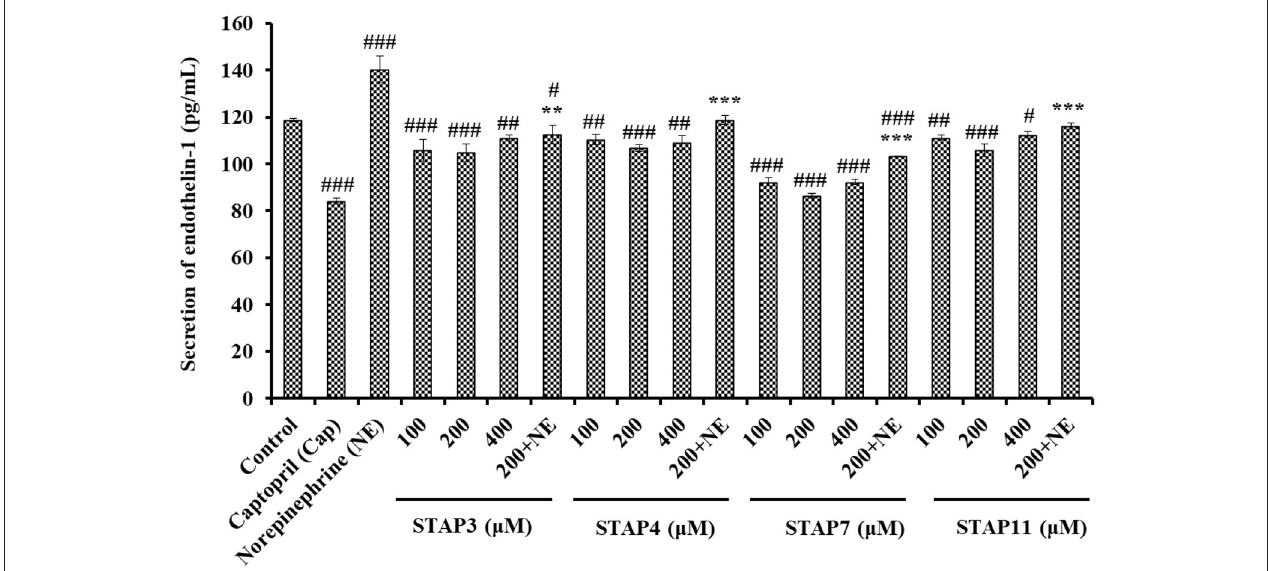
FIGURE 8 | The endothelin-1 (ET-1) secretion of HUVECs treated with STAP3, STAP4, STAP7, and STAP11 for 24h, respectively. Cell group treated with captopril (Cap) was designed as a positive control. ### P < 0.001, ## P < 0.01, and # P < 0.05 vs. control group; *** P < 0.001 and ** P < 0.01 vs. norepinephrine (NE) group. STAP11 treatments and decreased to 112.47 ± 3.95, 118.68 ± 1.81, 103.39 ± 0.08, and 116.15 ± 1.2 pg/ml at 200 µ M ( P <